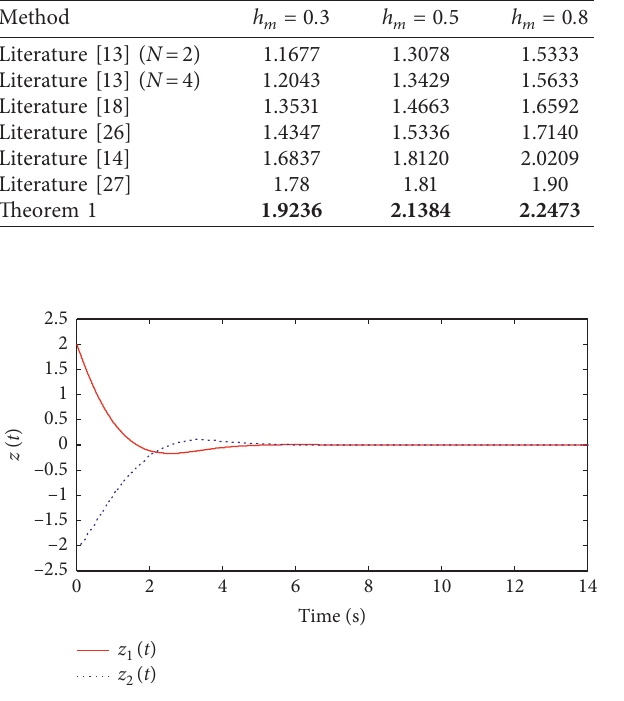
Figure 1: State response curve of x ( t ) when h